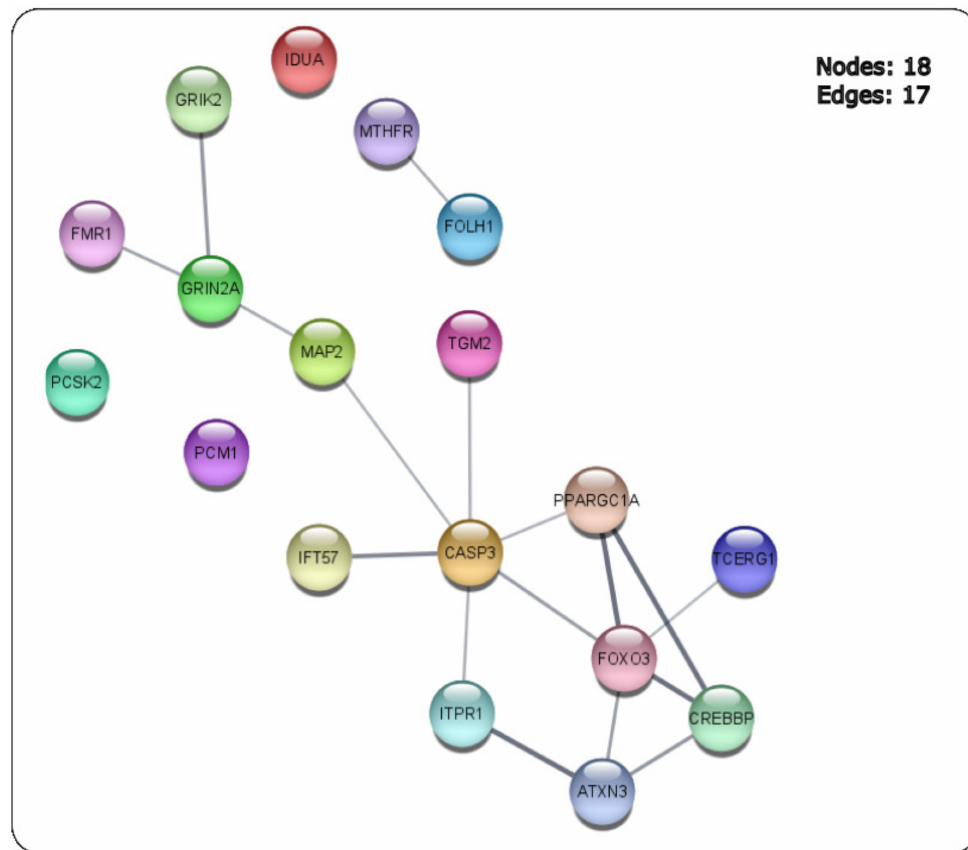
Figure 12. PPI network of the 18 HD-related hub genes identified to be shared between the public databases and the HD DEGs between the three GEO